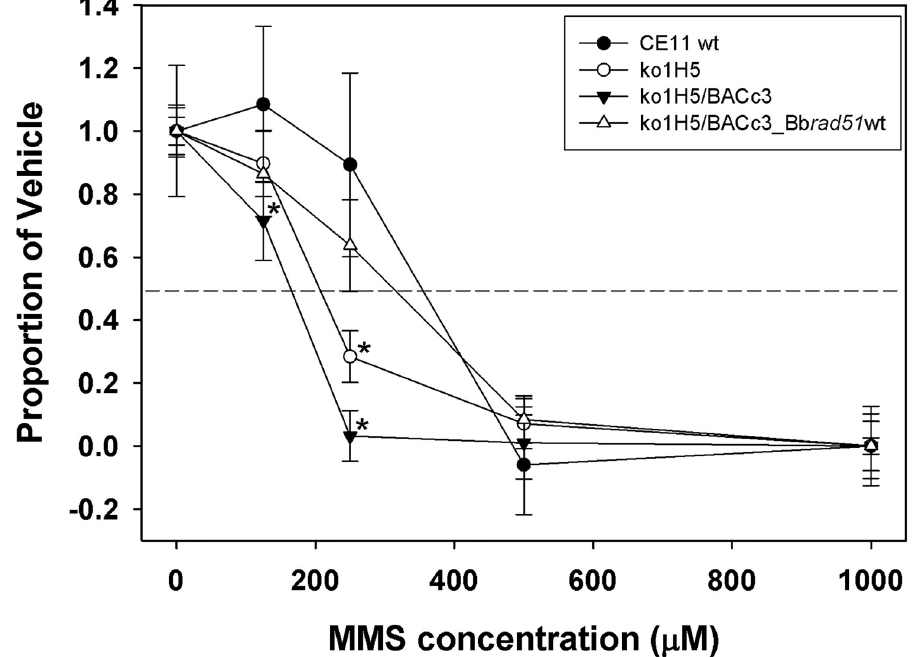
Fig 8. Complementation of the MMS-sensitivity phenotype by Bb rad51 expressed from the BbACc3 platform. B . bovis parasites of the CE11 (wild type), ko1 H5 (Bbrad51 knockout), ko1 H5/BbACc3_Bb rad51 wt, and ko1 Ht/BbACc3 lines were exposed to varying concentrations of MMS for 90 minutes, followed by drug washout. Parasites then were placed back into culture for 72h, and growth assessed by the SybrGreen method. Growth characteristics were plotted as the growth of each line relative to itself, employing 0 μ M as maximal growth and 1000 μ M MMS as no growth. Asterisks indicate a difference from the CE11 sample, based upon a one-way ANOVA, using CE11 as control group (significance values, p = 0.05 at 125 μ M, < 0.001 at 250 μ M MMS). The presence of BbACc3_Bb rad51 wt complemented ko1 H5 sensitivity to 250 μ M MMS to a level that was not significantly different from wild-type parasites. The presence of BbACc3 sequences, however, appears to impact somewhat the overall robustness of parasites, consistent with a fitness cost in retention of the